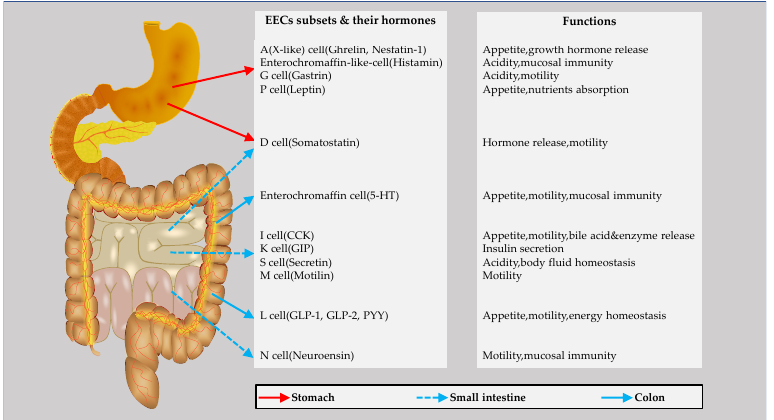
Figure 1. Schematic illustration of enteroendocrine cell (EEC) subsets in the gastrointestinal tract, as well as a demonstration of the major secretary hormones and their functions. 5-HT, 5-hydroxytryptamine; CCK, cholecystokinin; GIP, glucose-dependent insulinotropic peptide; GLP-1, glucagon-like peptide-1; GLP-2, glucagon-like peptide-2; PYY, peptide YY. Luminal contents, such as nutrients and microbiota, stimulate the specialised sensory microvilli of EECs so as to release hormones [58]. The release of intestinal hormones pack- aged into secretory vesicles is controlled by increased concentrations of cytoplasmic cal- cium, as well as cyclic adenosine monophosphate (cAMP). Only in this condition can EECs detect ingested food, which is macronutrients broken down into their ingredients like glucose and amino acids, as well as fatty acids. Specialised receptors and transporters of EECs detect small compounds so as to trigger the secretion of hormones. 4.2. Changes of Enteroendocrine System in IBD Recent studies have shown that the enteroendocrine system has a pivotal role in the pathogenesis of IBD, which is demonstrated by the alteration of EEC numbers and their secreted hormones in IBD patients and rodent colitis models. For instance, two enteroen- docrine markers, ubiquitination factor E4A ( UBE4A ) and paired-like homeobox 2b ( Phox2B ), are reported to significantly augment the distal ileum of patients with Crohn’s disease [59]. Related papers have shown that the amount of colonic PYY and pancreatic polypeptide (PP), as well as the number of oxyntomodulin-producing EECs, were de- creased in patients with Crohn’s disease [60]. Salhy et al. [61] set up rat colitis models induced by trinitrobenzene sulfonic acid (TNBS) and found that, compared with the con- trol group, the amount of PYY, CgA and pancreatic polypeptide-producing cells obvi- ously decreased in the TNBS group, contrary to the number of serotonin and oxynto- modulin, as well as somatostatin-producing cells, significantly increased in the TNBS group. Furthermore, Salhy et al. [62] induced colitis models by DSS in rats. They discov- ered that the amount of CgA, serotonin, PYY and oxyntomodulin cells got higher, but the number of pancreatic peptide and somatostatin cells got lower in DSS-induced rats than in the controls. The above studies indicated EECs and their secreted-hormone responses to colitis in rats. Strid et al. [63] reported that the serum and plasma CgA in IBD patients significantly increased; however, the CgA levels in stool only increased in patients with ulcerative colitis, which did not correlate with disease severity. CgA and its derivatives like VS and CST, have been proven to be able to modulate antimicrobial property, which suggests that the alteration of CgA in EECs relates to the variation of the microbial com- position, richness and diversity in the gut [64,65]. Other enterohormones such as CCK, GLP-1, 5-HT, motilin and gastrin also change during the development of IBD [66 – 72].